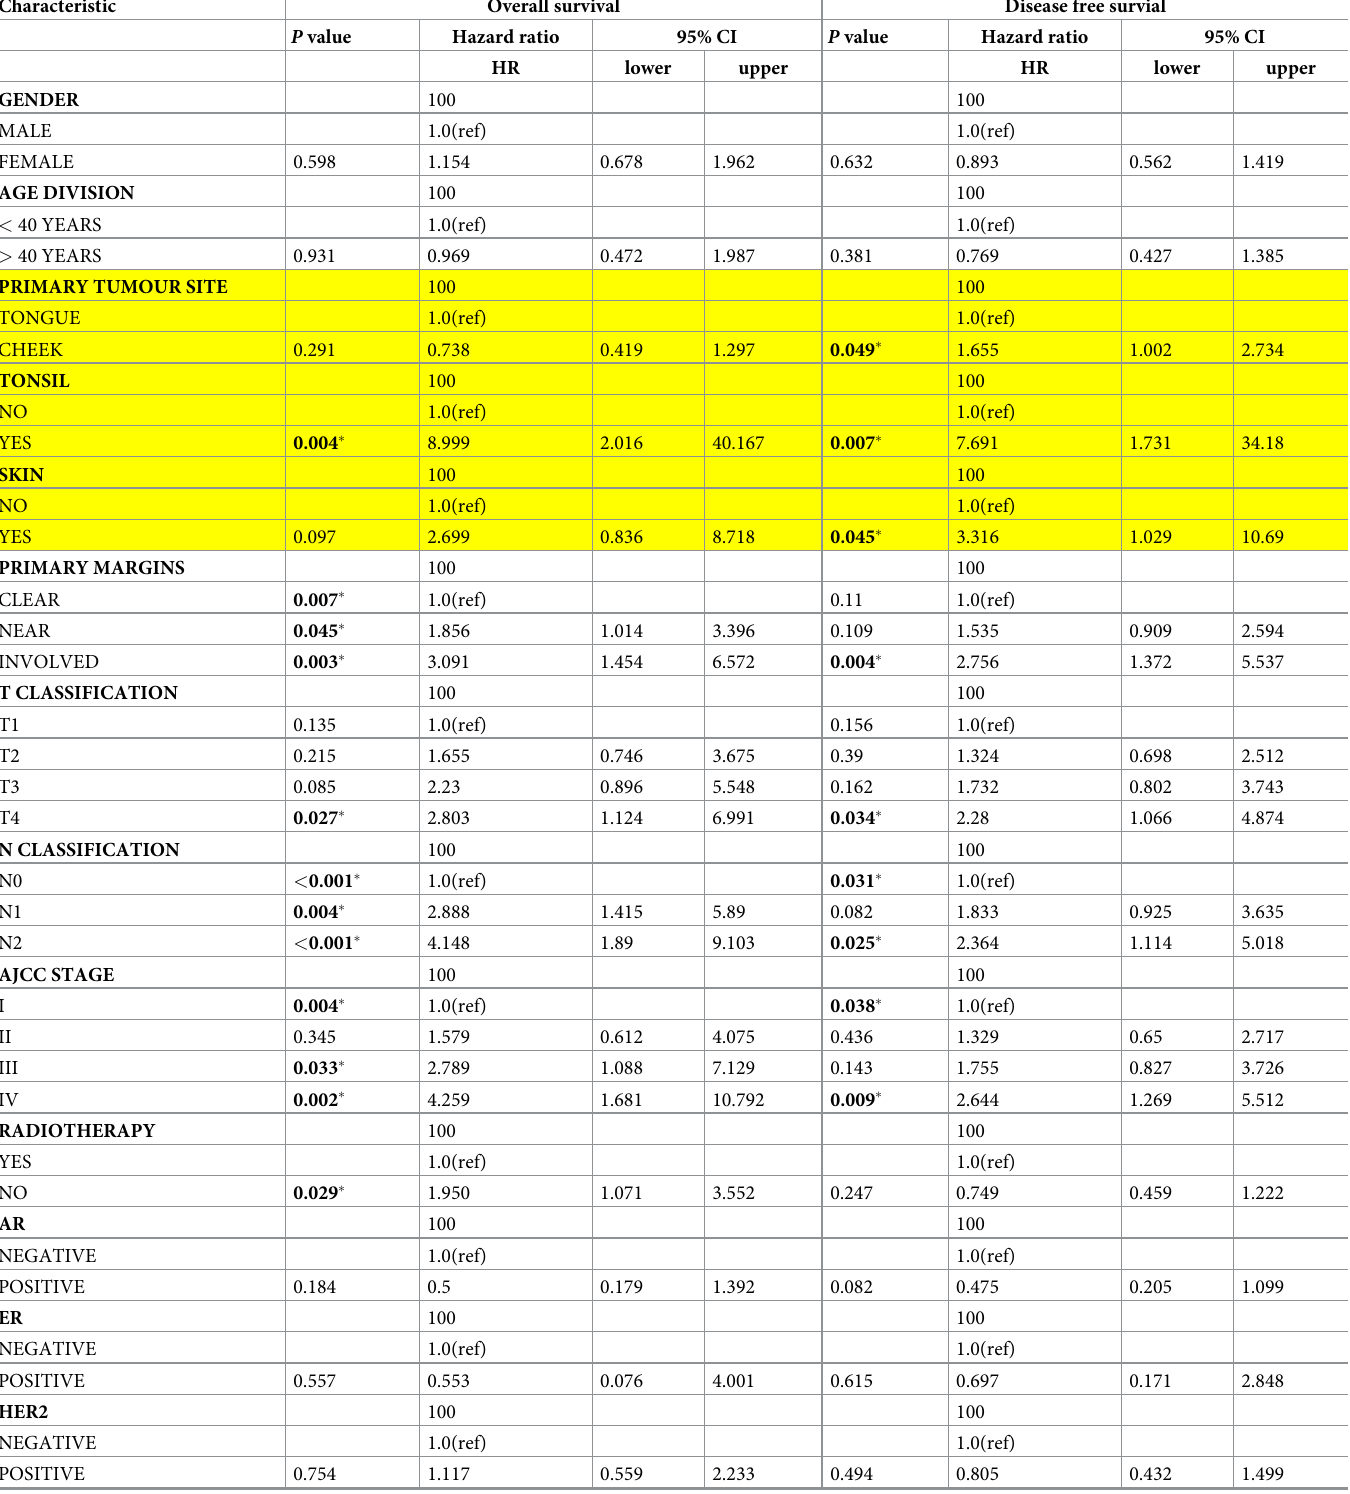
Table 3. Cox regression univariate survival